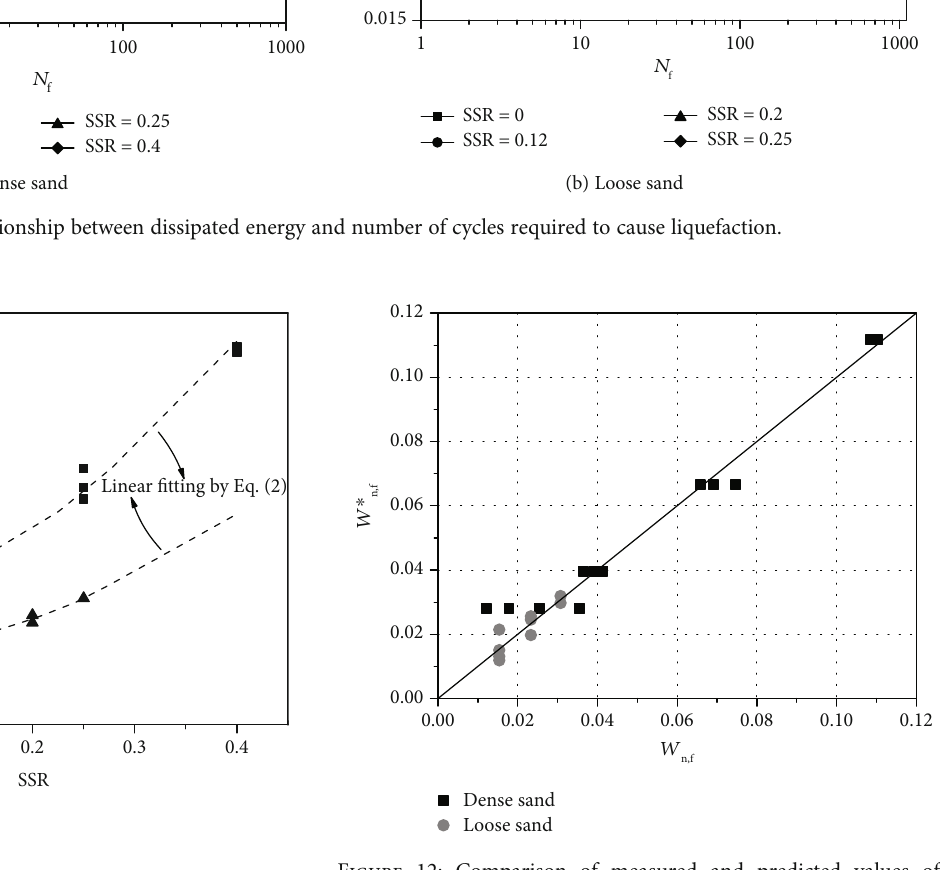
Figure 11: Relationship between the dissipated energy and static stress ratio.